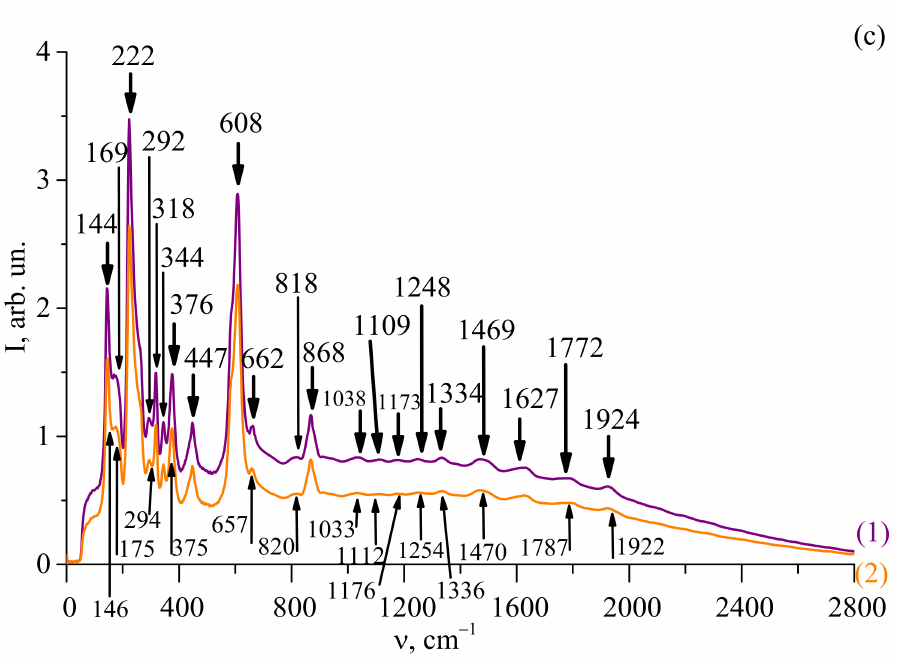
Figure 3. Raman spectra at the backscattering geometry in the region of fundamental and overtone vibrations of LiNb 0.4 Ta 0.6 O 3 ( a ), LiNb 0.5 Ta 0.5 O 3 ( b ) and LiNb 0.6 Ta 0.4 O 3 ( c ) ceramic samples. Curves (1) and (2) correspond to two different points of the corresponding sample.